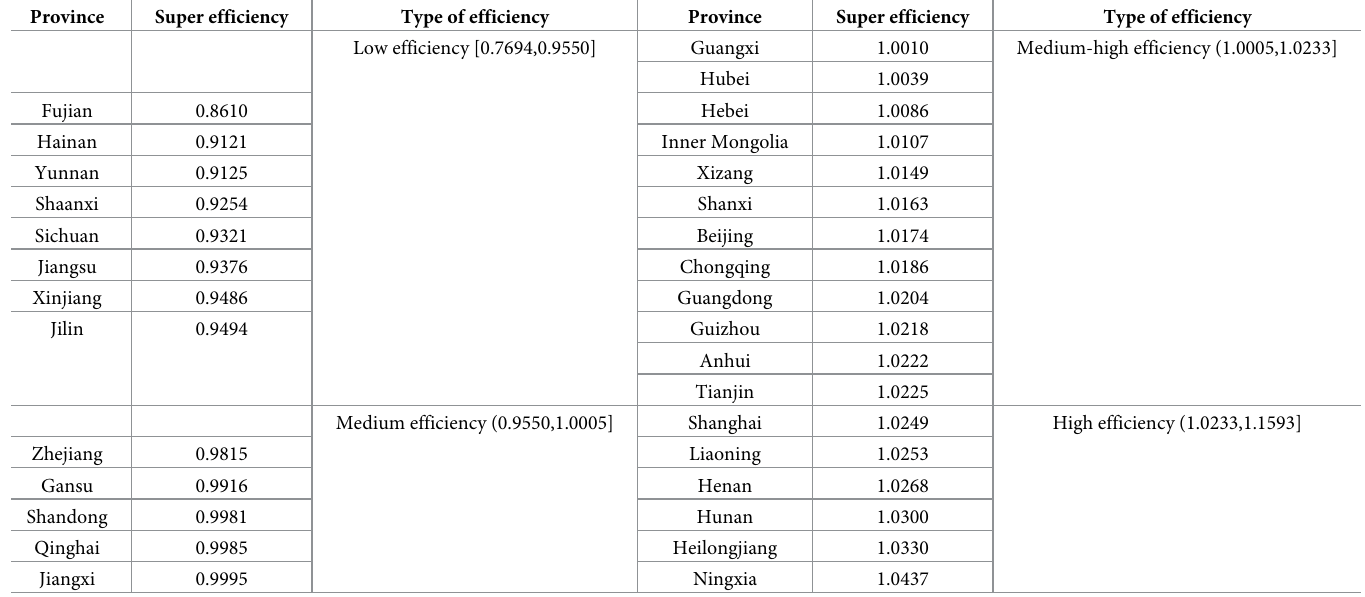
Table 4. Regional distribution of super